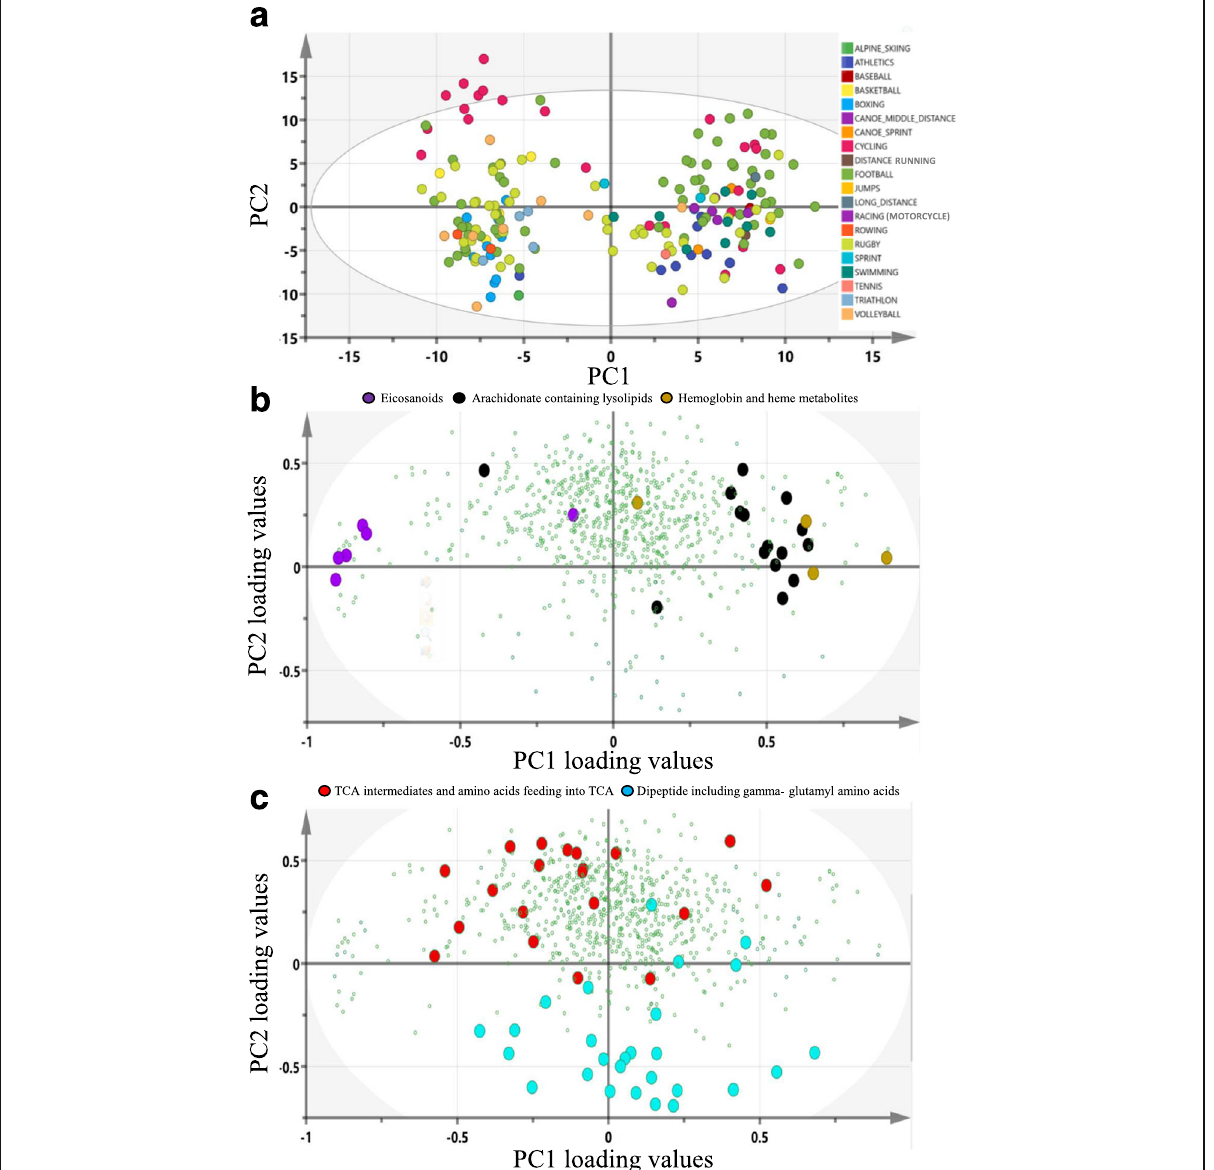
Fig. 1 PCA analysis of athlete metabolomics data. a A score plot of PC1 and PC2 indicating clustering of samples into two groups according to PC1. Neither PCs is explained by sport type or class. b , c Loading plots offering clues on what the two PCs may represent: The heme/hemoglobin metabolites suggests a hemolysis signature for PC1 ( b ) while the TCA energy metabolite highlighted by PC2 indicates an energy generating process which may be associated with exercise ( c